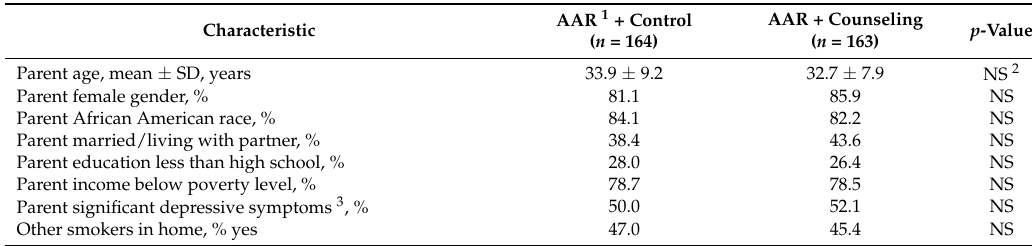
Table 1. Baseline participant characteristics by condition ( n =